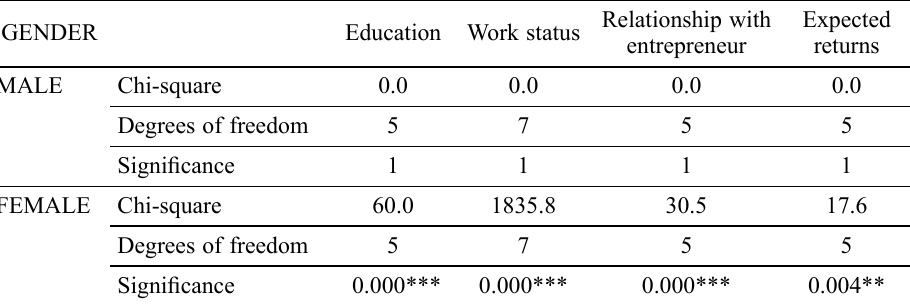
Table A1. Chi square test